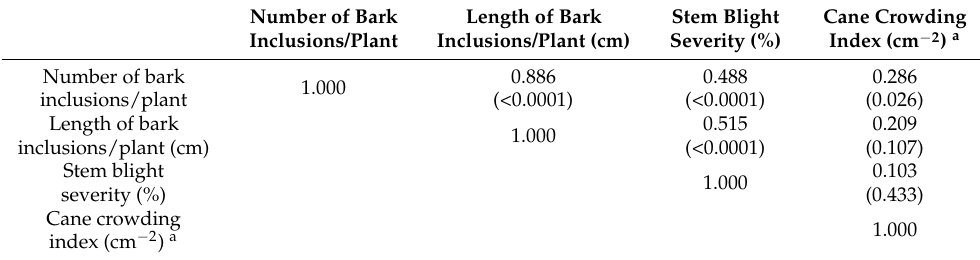
Table 2. Pearson’s correlation coefficients and associated p -values (in parentheses) showing the associations among bark inclusion, Botryosphaeria stem blight, and plant architecture variables in Farthing southern highbush blueberry ( n = 60, study 3). Number of Bark Length of Bark Stem Blight Inclusions/Plant Inclusions/Plant (cm) Severity (%)